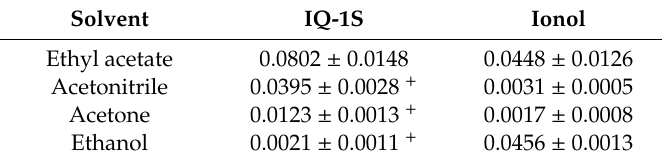
Figure 4. Decay of DPPH radical in control sample and during the reaction with IQ-1S and ionol in acetone ( A ), in acetonitrile ( B ), in ethyl acetate ( C ), and in ethanol ( D ). The initial concentrations of DPPH radical and IQ-1S or ionol were always the same. Table 2. Reaction rate constants (min − 1 ) DPPH with IQ-1S and ionol in various solvents.